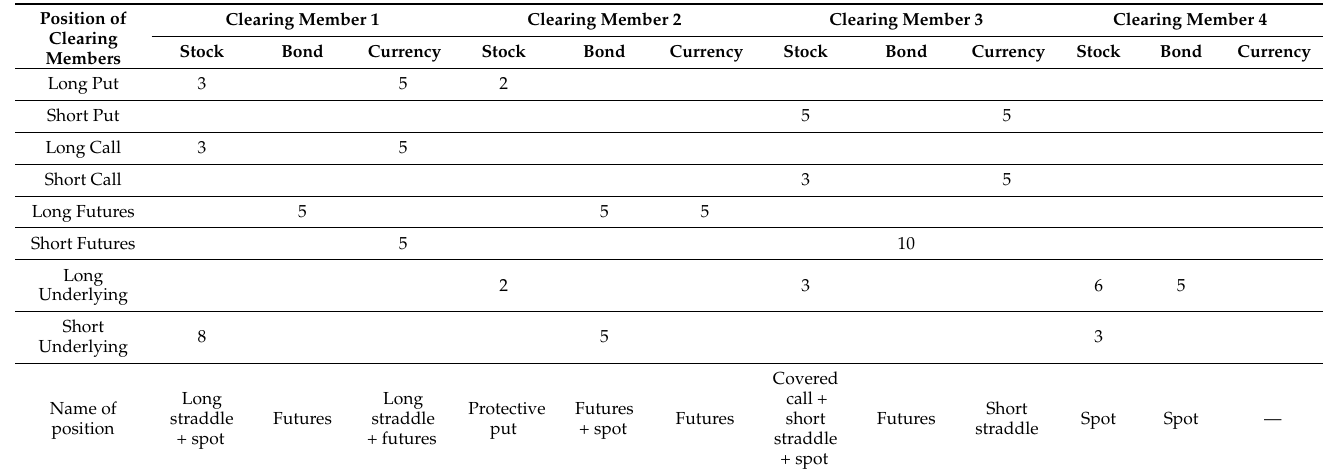
Table 4. Number of positions of clearing